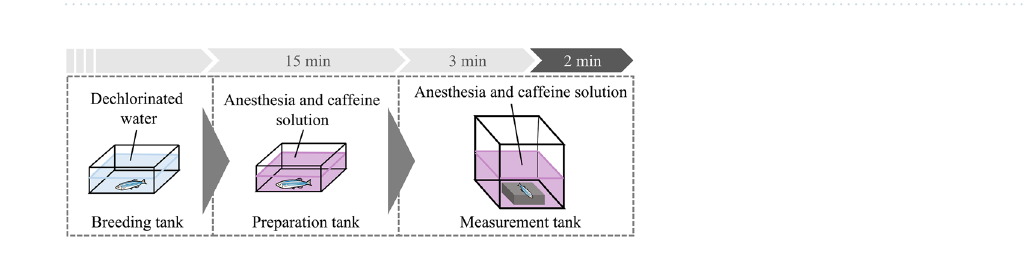
Figure 4. Experimental protocol of the restraint